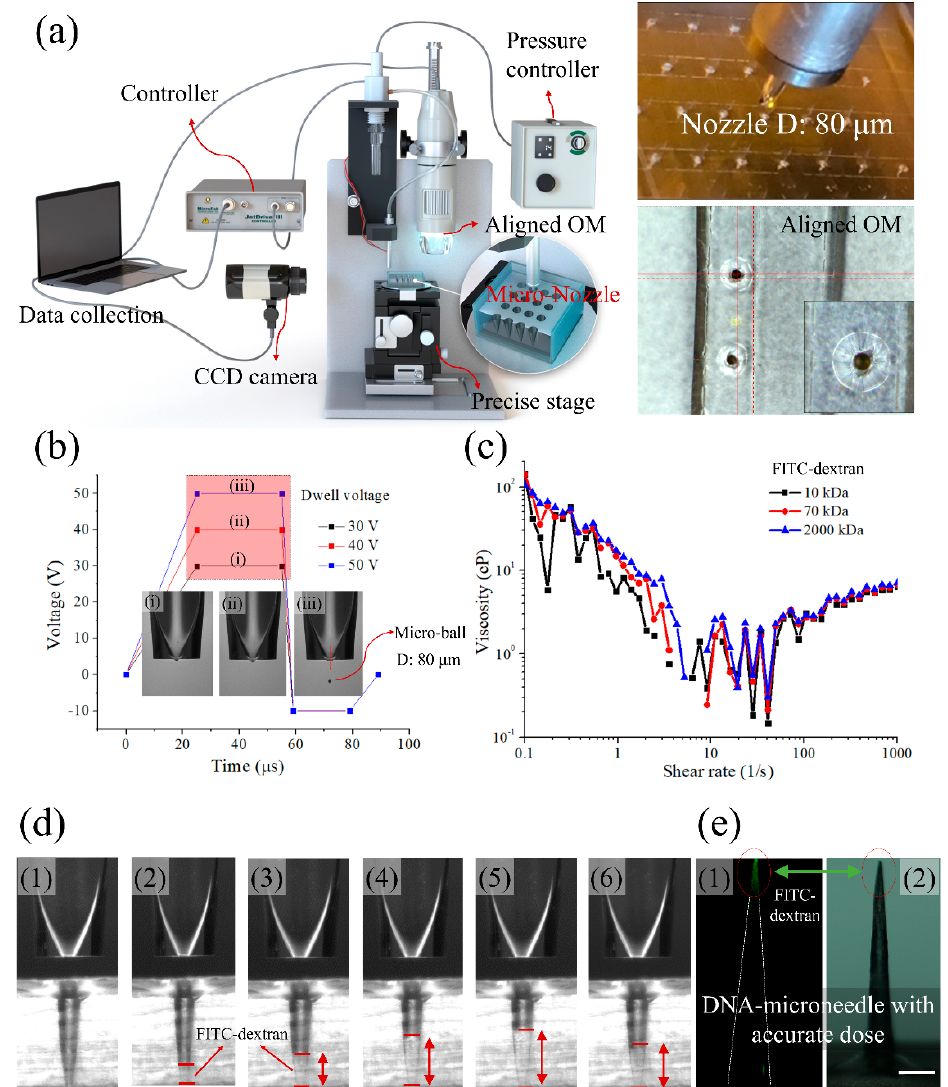
Figure 5. ( a ) Schematic diagram of the micro-jetting system for drug loading. Experimental images of the mold and nozzle, nozzle and mold for positioning, and top view image. The inset image shows the straightness of FITC solution loading into the mold. ( b ) Driving waveform conditions for stable loading of FITC at (b.i) 30 V, (b.ii) 40 V, and (b.iii) 50 V. ( c ) The effect of shear rate on steady shear viscosity of FITC-dextrans of different molecular weights (10 mg/10 mL), ( d ) micro-jetting of solution in the micro mold after (d.1) 0 drops, (d.2) 50 drops, (d.3) 100 drops, (d.4) 150 drops, (d.5) 200 drops, and (d.6) 1000 drops. ( e ) (e.1) Confocal microscopy image of the fabricated DNA needle-based FITC loaded by micro-jetting; (e.2) optical image of the microneedle (scale bar: 200 μ m).